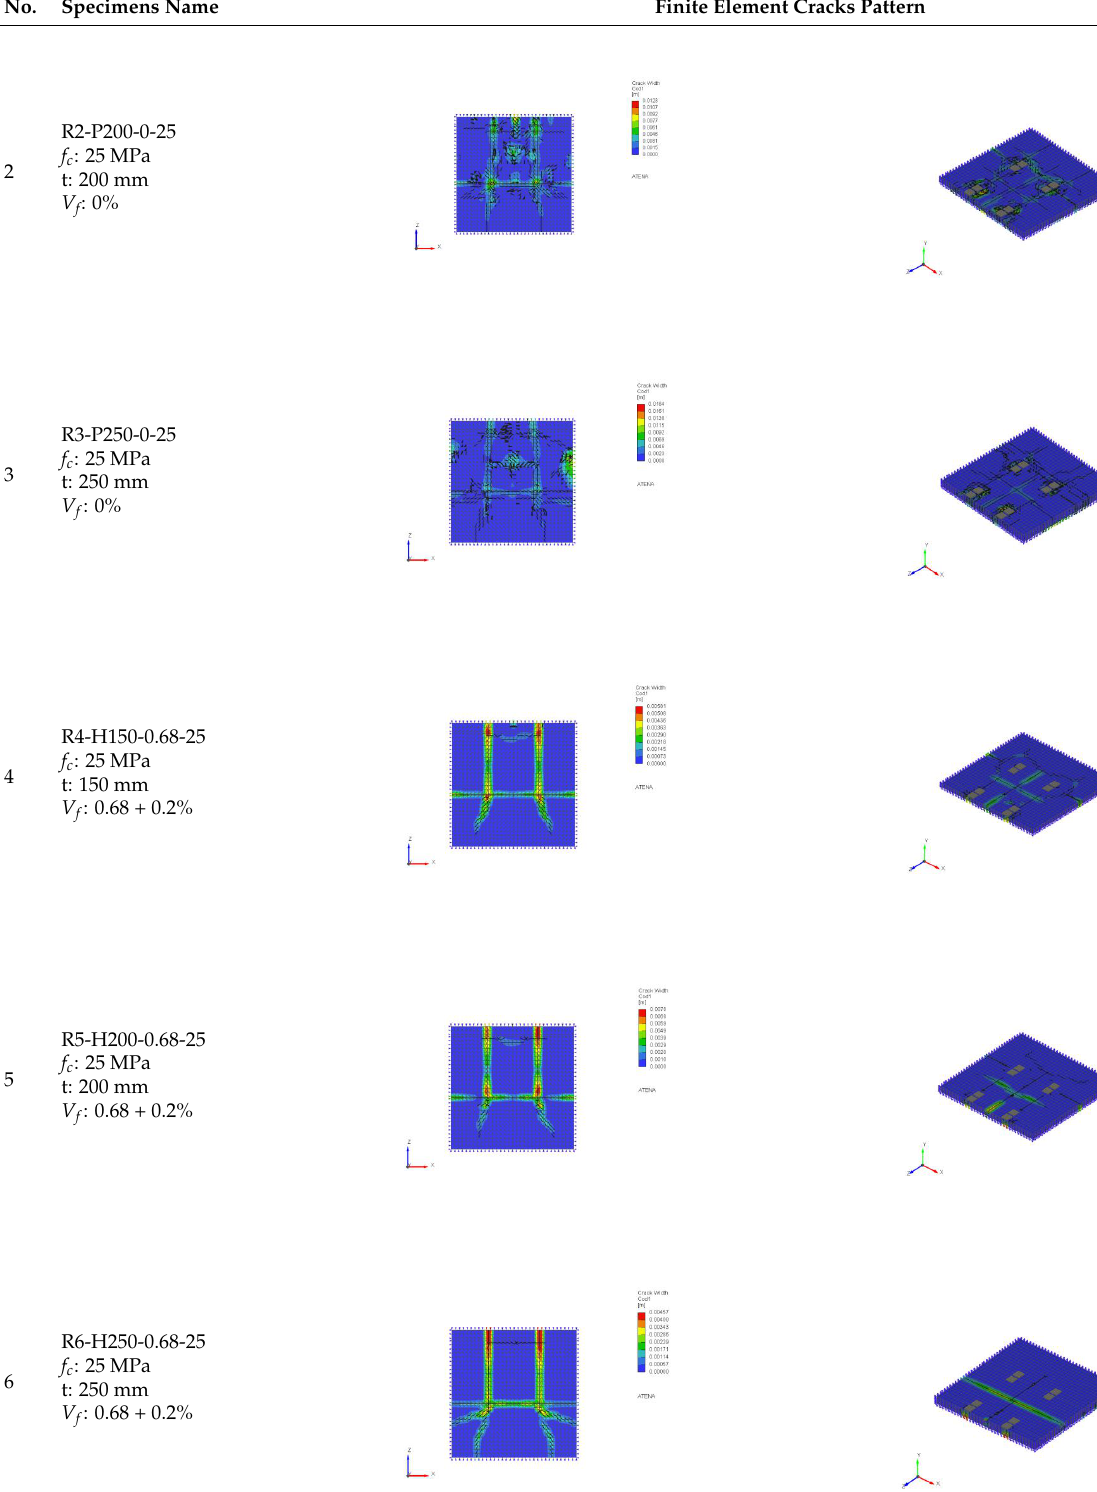
Table A2. Displays the finite element cracks pattern of the rigid pavement specimens .